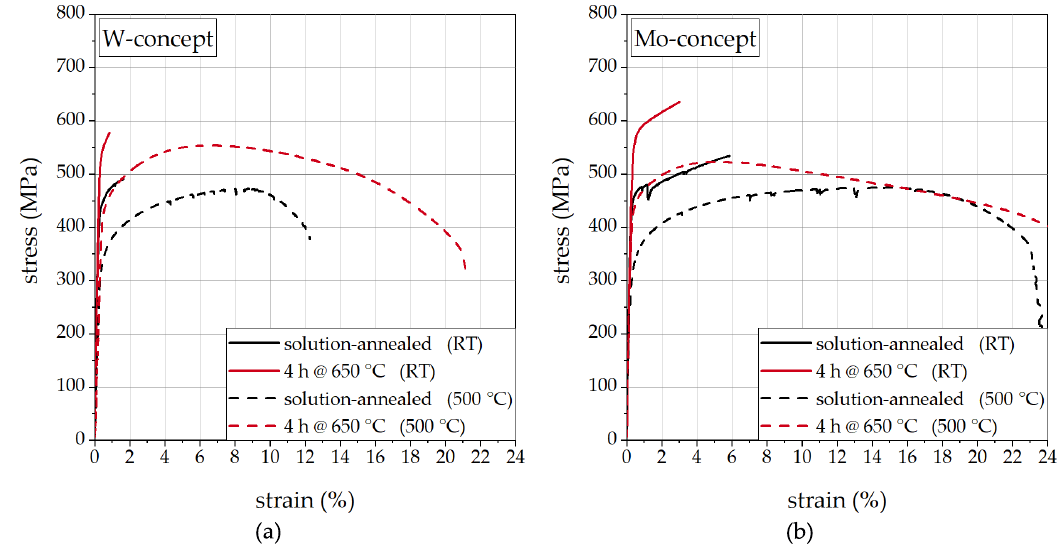
Figure 8. Stress–strain curves recorded at room temperature and at 500°C of tensile samples of W-( a ) and Mo-concept ( b ) in solution annealed state as well as aged at 650°C for